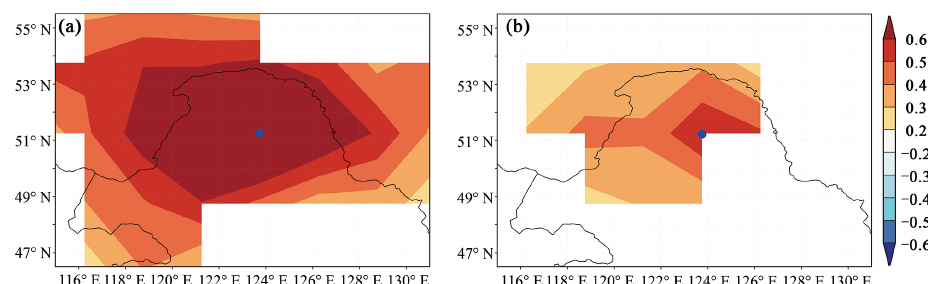
Figure 5. Spatial correlation fields between (a) the instrumental and (b) reconstructed annual Dai-PDSI for the Daxing’an Mountains and the regional Dai-PDSI during the period 1911–2010 (http://climexp.knmi.nl/, last access: 30 May 2017). The blue circle is the reconstructed PDSI grid.